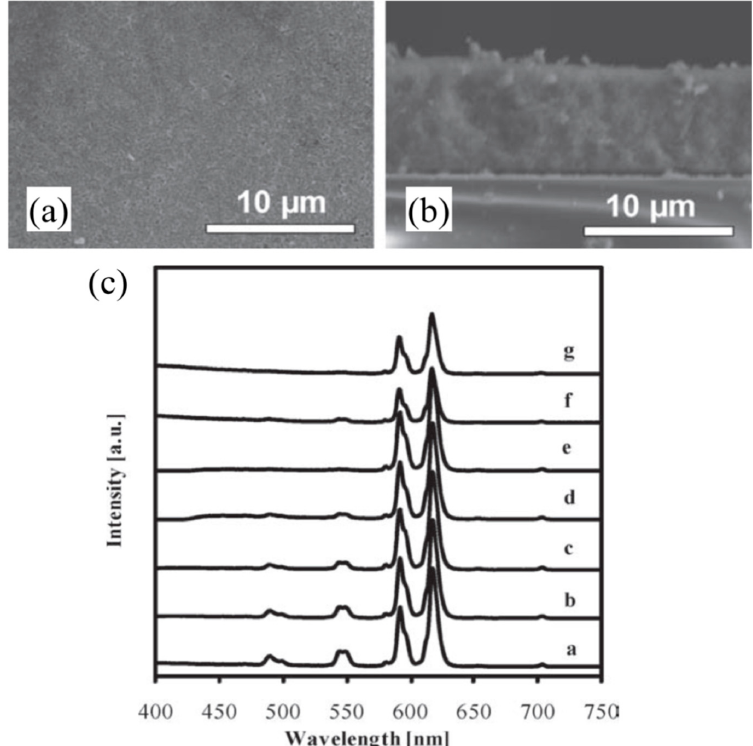
Figure 11. SEM images of a Tb 0.5 Eu 0.5 -MOF film viewed from: ( a ) the surface and ( b ) the cross section; ( c ) Spectra of luminescent Eu 1-x Tb x -MOF films with different Tb 3+ /Eu 3+ mole ratios: a, 2.75; b, 2.44; c, 1.95; d, 1.46; e, 1.02; f, 0.40; g, 0.30. Reprinted with permission from Reference [79]. Copyright 2010 WILEY-VCH Verlag GmbH & Co., (Weinheim, Germany).